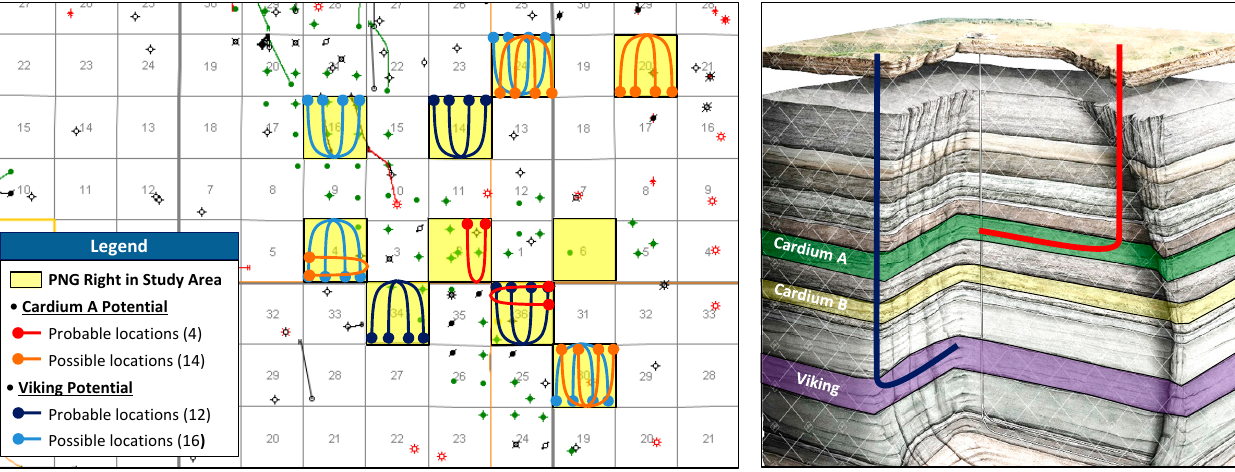
Figure 12. Development summary in the Crossfield study